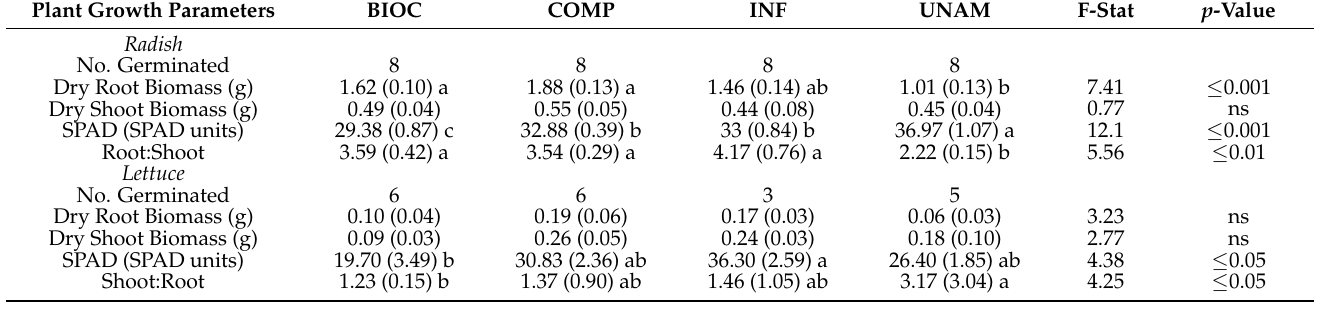
Table 7. Plant growth parameters: number of plants germinated, dry root biomass, dry shoot biomass, leaf chlorophyll (SPAD), and root-to-shoot/shoot-to-root ratio (root:shoot/shoot:root) reported for radish and lettuce at the end of the experiment for soils amended with biochar (BIOC), compost (COMP), inorganic fertilizer (INF) and unamended control (UNAM). Lower case letters within each row represent statistical differences at a minimum of p ≤ 0.05 or as indicated by F-stat and p -values in the last column. Statistical tests were performed using a two-way Analysis of Variance (ANOVA) or Kruskal-Wallis if data could not be normalized. Tukey HSD and Dunn’s test (non-normal data).